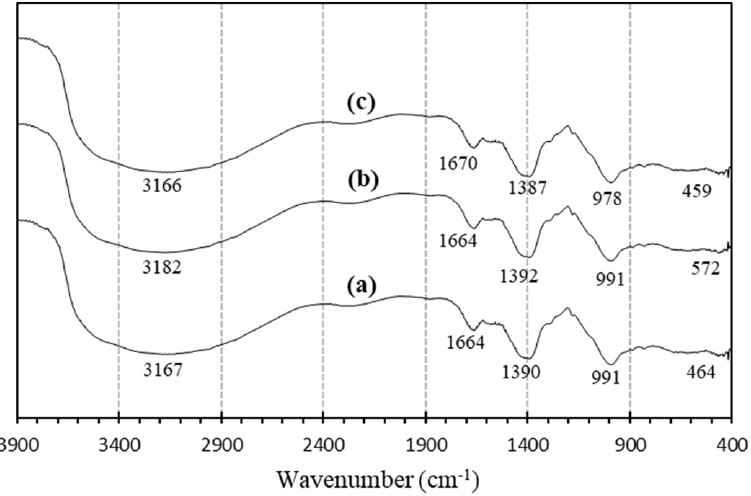
Figure 10. FTIR spectra of geopolymer paste with the sodium silicate from RHA: ( a ) Geo N-8, ( b ) Geo N-10, and ( c ) Geo N-12.